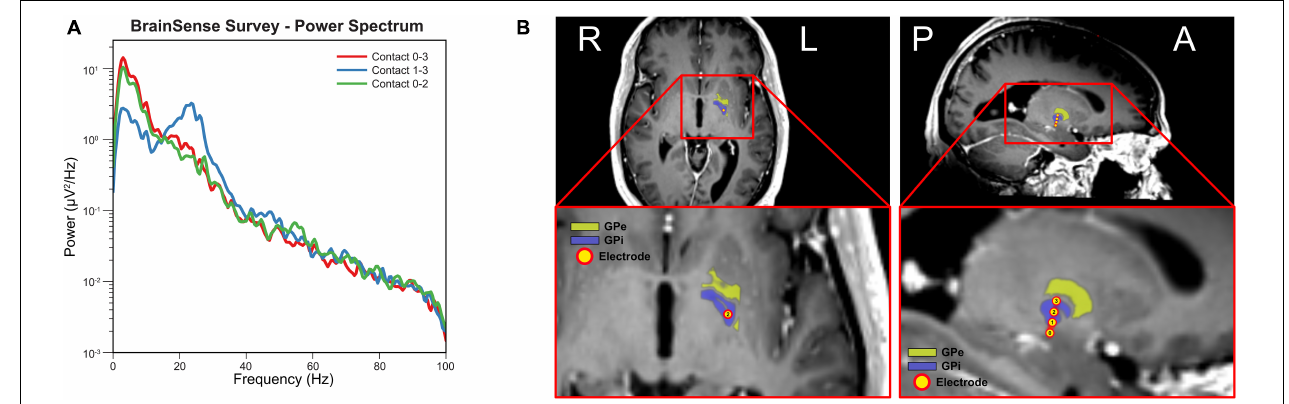
FIGURE 1 | Electrode localization and baseline electrophysiology. (A) Power spectral density for each sensing-enabled contact pair showing a beta peak at 23.44 Hz for sensing contact pair 1–3 (data recorded during off stimulation). (B) Electrode contacts were identified in the fused post-operative CT image and pre-operative T1 MRI image. Electrode trajectory was close to a vertical trajectory (AC-PC angle 74-degree and central line angle 5-degree). Electrode contact 0 was outside of the GPi border while contact 1 to 3 were inside of GPi border. (Yellow atlas: GPe; Blue atlas: GPi; and Yellow dots: electrode contacts).